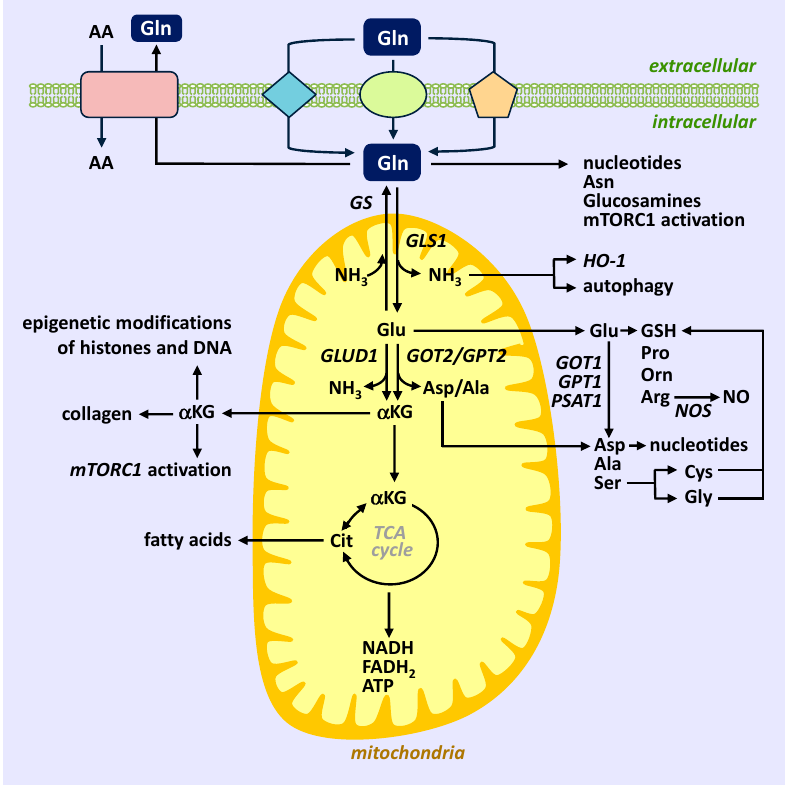
Figure 1. Summary of Gln transport and metabolism in immune and vascular cells. Gln is transported into cells through several membrane transporters and modulates the entry and intracellular concentration of other AA through its interaction with Gln transporters. Following uptake, Gln is utilized in the cytosol to generate nucleotides, Asn, and glucosamines and may activate mTORC1.